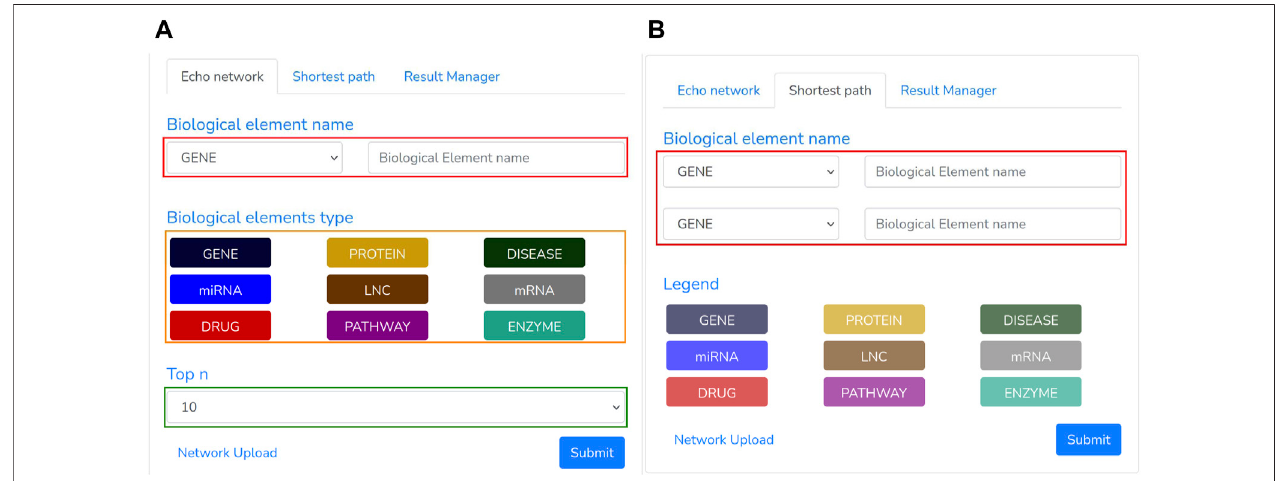
FIGURE5| EchoNetworkandShortestpathpanel:The fi rst (A) isusedtoextracttheneighborhoodofagivennodeandtype. (B) Thesecondone,instead,returns the shortest path among two speci fi ed biological entities.